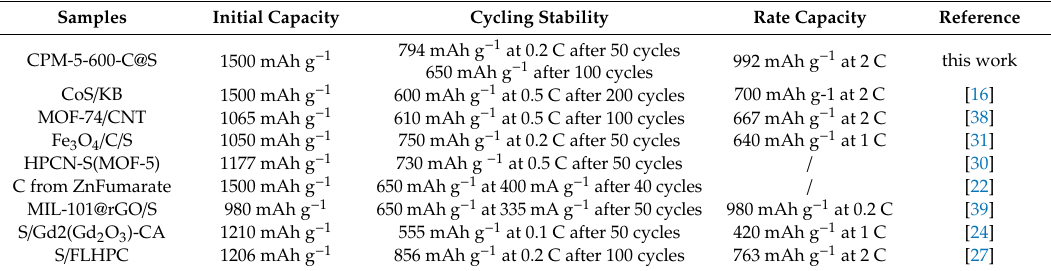
Figure 9. The EIS of AB@S, CPM-5@S, CPM-5-C600@S electrodes in Li-S batteries before cycles and the CPM-5-C-600@S-100 cycles electrodes. Table 1. Electrochemical performances of CPM-5-C-600@S electrode in this work and other similar composition reported in other references as cathode in Li-S